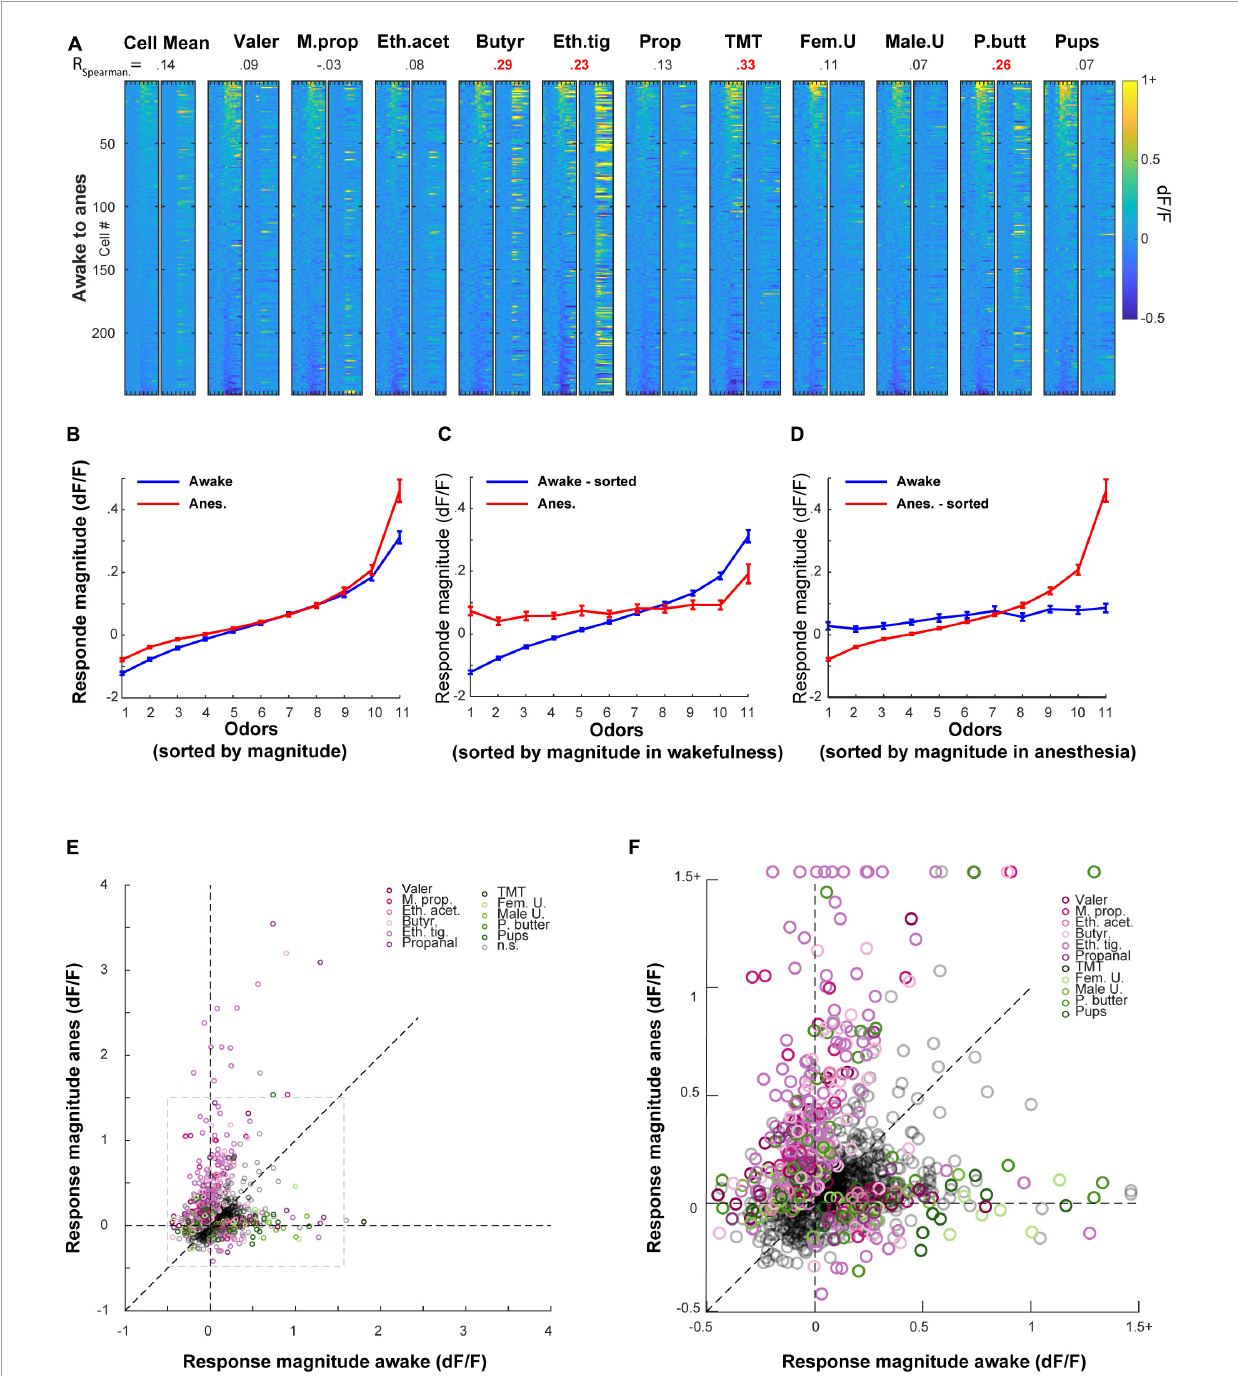
FIGURE5 Odor responses in the awake state are poor predictors of the response in the anesthetized state, and vice versa . (A) All cell odor pairs recorded in both awake and anesthetized sessions, sorted by the response magnitude measured in the awake session. For each odor, the left column shows the sorted cell-odor pairs in the awake session and the adjacent right column shows the same cell-odor pair under anesthesia. Odor presentation (2 s) is marked by a red line at the bottom of each column. Correlation values denote the Spearman correlation between the cell-odor pairs in both states, where statistically significant correlations are in red. (B) Response magnitude in ranked order, before and after anesthesia. Cell odor pairs were sorted separately for awake and anesthetized recordings. (C) Response magnitude in ranked order, before and after anesthesia. Cell odor pairs were sorted in a paired manner according to their response in the awake recording session. (D) Same as C, but pairs were sorted in a paired manner according to their response in the anesthetized recording session. (E) Response magnitudes of all responsive cell-odor pairs before and after anesthesia. Color dots mark odor identity of responses that differed significantly between states ( ∼ 40% of all significant responses in either state). Gray dashed square marks the area that is magnified in panel (F) . (F) Magnification of the dashed gray square in panel (E)